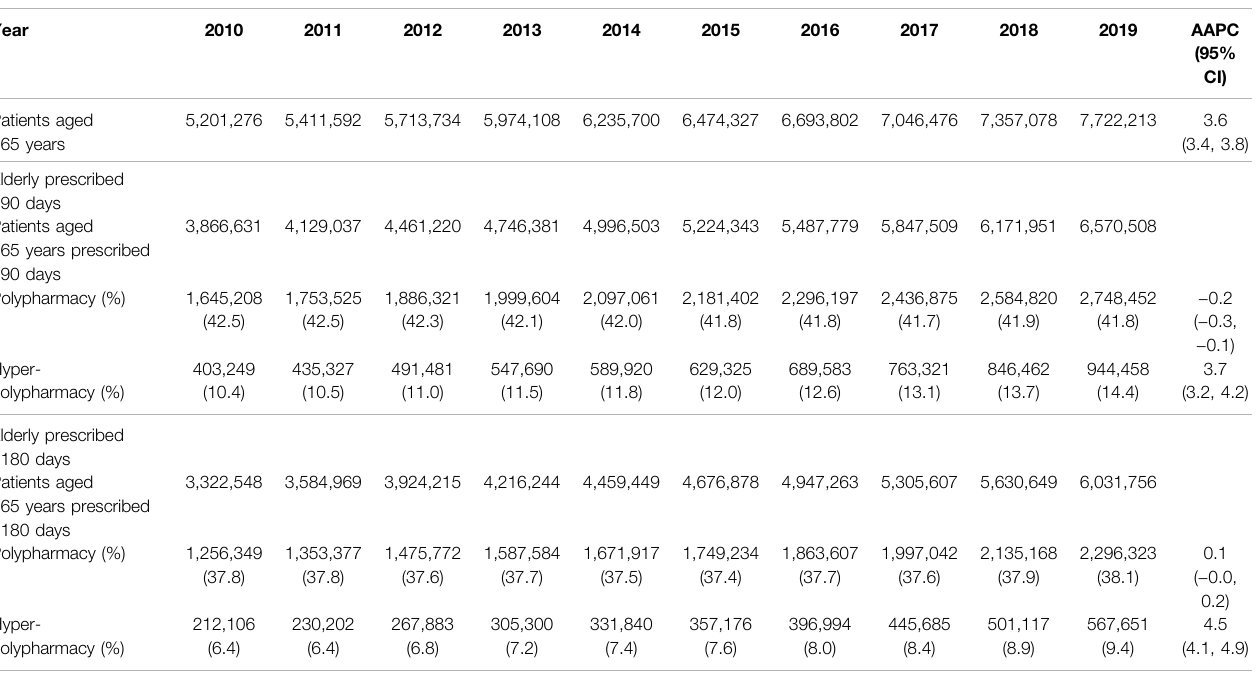
TABLE 2 | The trend of the prevalence of polypharmacy and hyper-polypharmacy among the elderly patients prescribed ≥ 90 and ≥ 180 days in 2010 – 2019